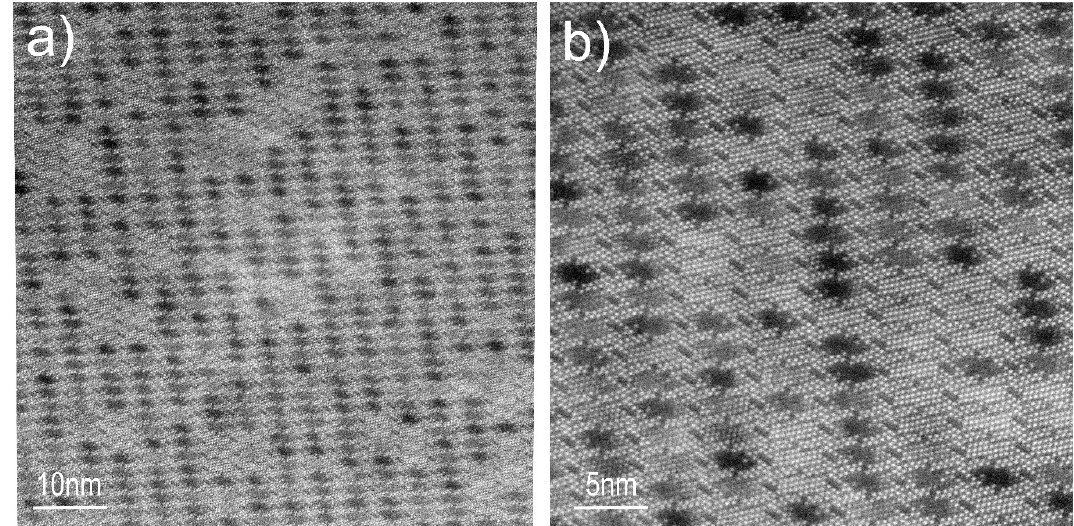
Figure 10. HAADF STEM images showing patterns realised by building blocks in the crystal structure of neyite down to the [010] zone axis (dark Pb-Bi-sulphosalt (phase D) in area (i) of foil 2; Figure 6h). Note the “zig-zag” pattern expressed as contrast variation in the ‘rhombic’ motifs forming parallel strips in ( a ); In ( b ) the structural motifs are shown by different orientations of the heavy atoms (bright dots; Bi, Pb), and dark contrast for units formed by lighter elements (Ag and Cu). Note the transitional, variable contrast for the rhombic motifs but the preservation of the geometrical outline. See the text for additional explanation.